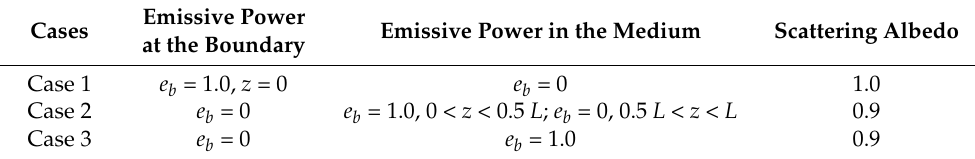
Table 1. Emissive power and scattering albedo for the cases